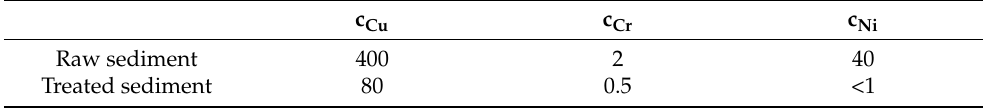
Table 5. Metal content in the sediment before and after treatment in (mg/kg d.m.). c